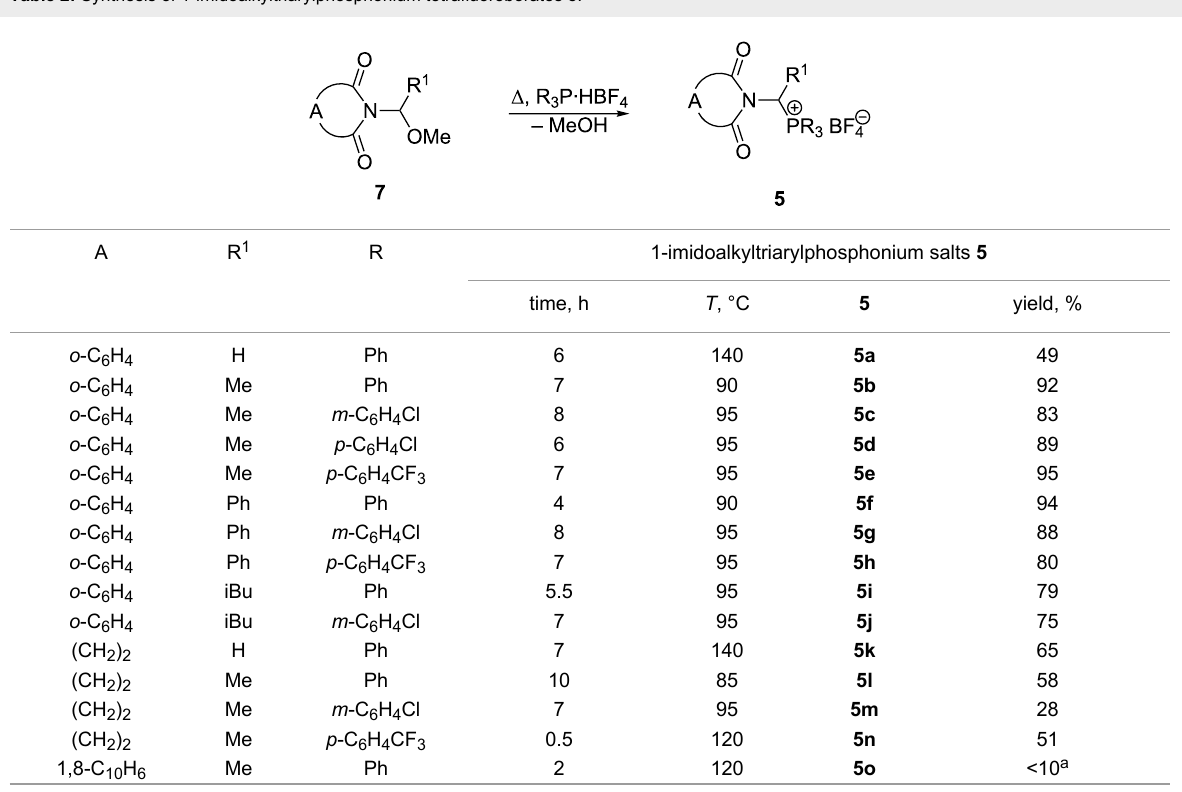
Table 2: Synthesis of 1-imidoalkyltriarylphosphonium tetrafluoroborates 5